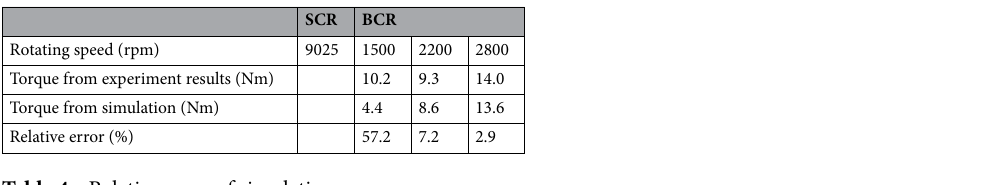
Table 4. Relative error of